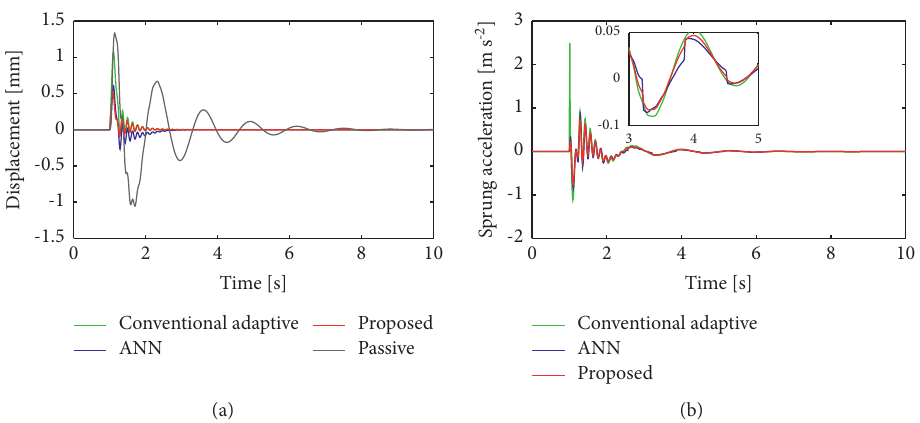
Figure 9: The comparison of sprung mass responses under bump wheel excitation for three different strategies: (a) displacement response and (b) acceleration